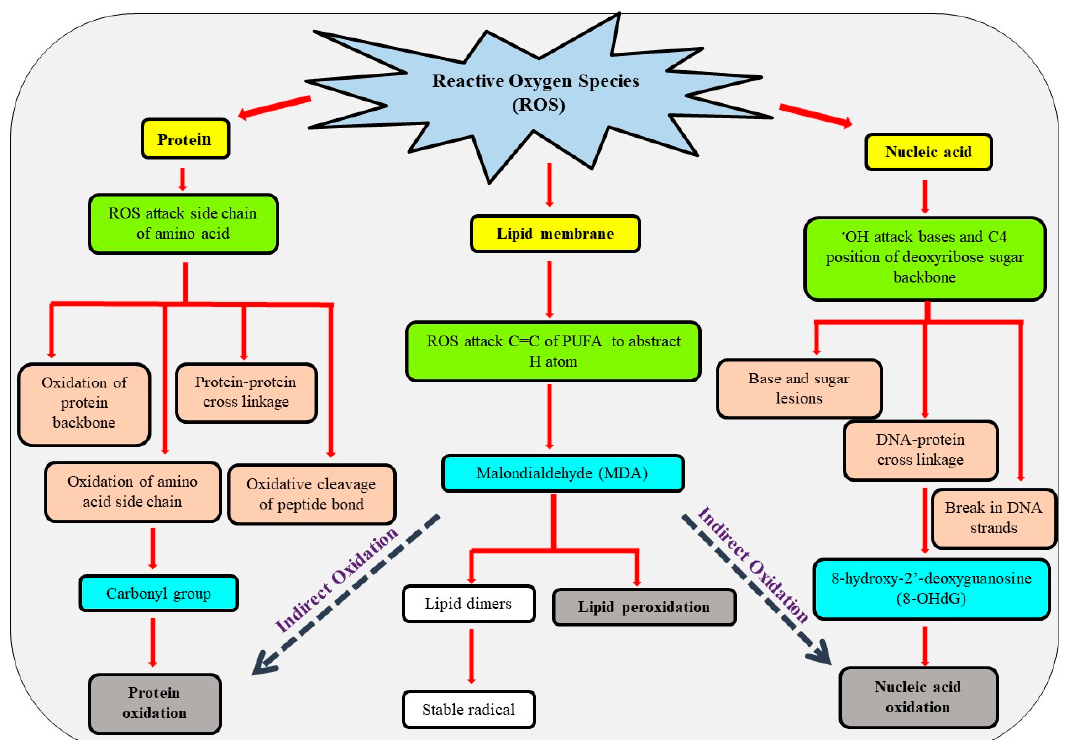
Figure 7. Reactive oxygen species attack biomolecules (proteins, membrane lipids, and nucleic acids) at different sites leading to oxidation that alters their structural and functional activities. Oxidation of biomolecules results in the formation of carbonyl group, malondialdehyde, and 8-hydroxy-2 ′ -deoxyguanosine, which are considered as a best marker of protein, lipid, and nucleic acid oxidation, respectively.